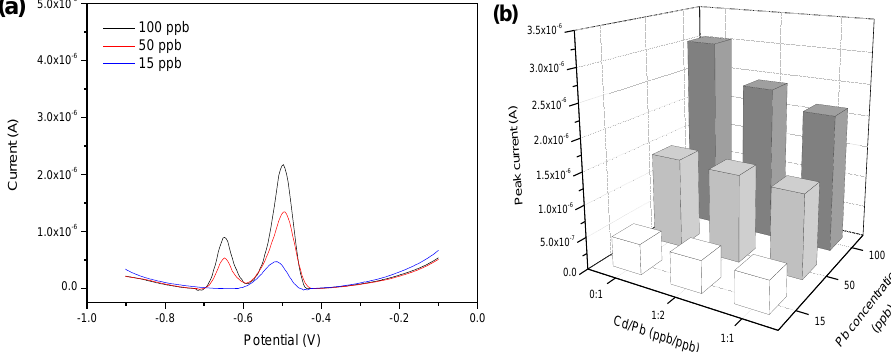
concentration of Cd 2+ ; ( b ) The analysis result of interference test data in the presence of Cd 2+ at different concentrations.